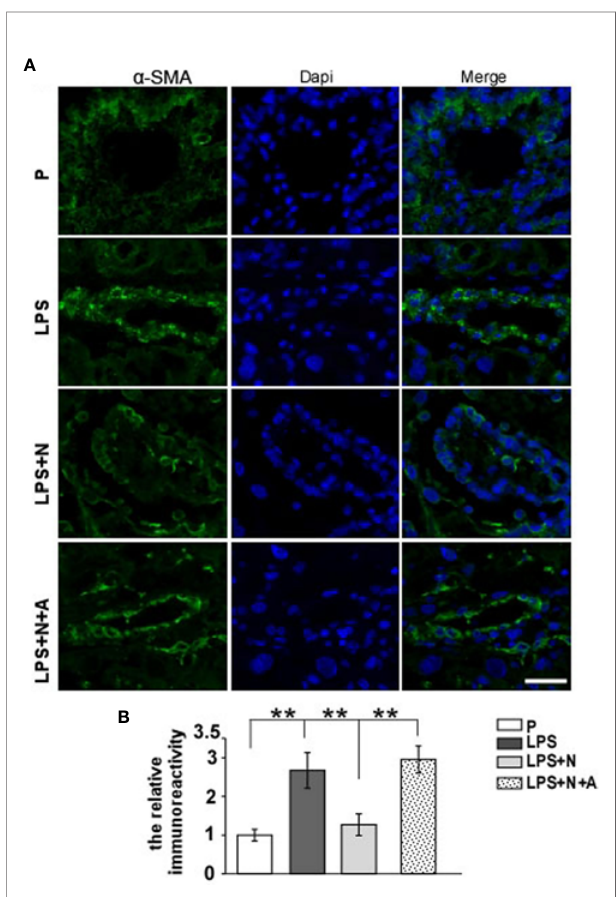
FIGURE 5 | Nicotine reduced the elevated expression of a -SMA and improved the impairment of spiral artery in placentas from the PE-like mice treated by LPS. (A) Representative immuno fl uorescent images for a -SMA in placentas from all experimental groups. Scale bar=30 m m. (B) Quantitative analysis showed changes in the relative immunoreactivity of placental a -SMA in all groups. **P <